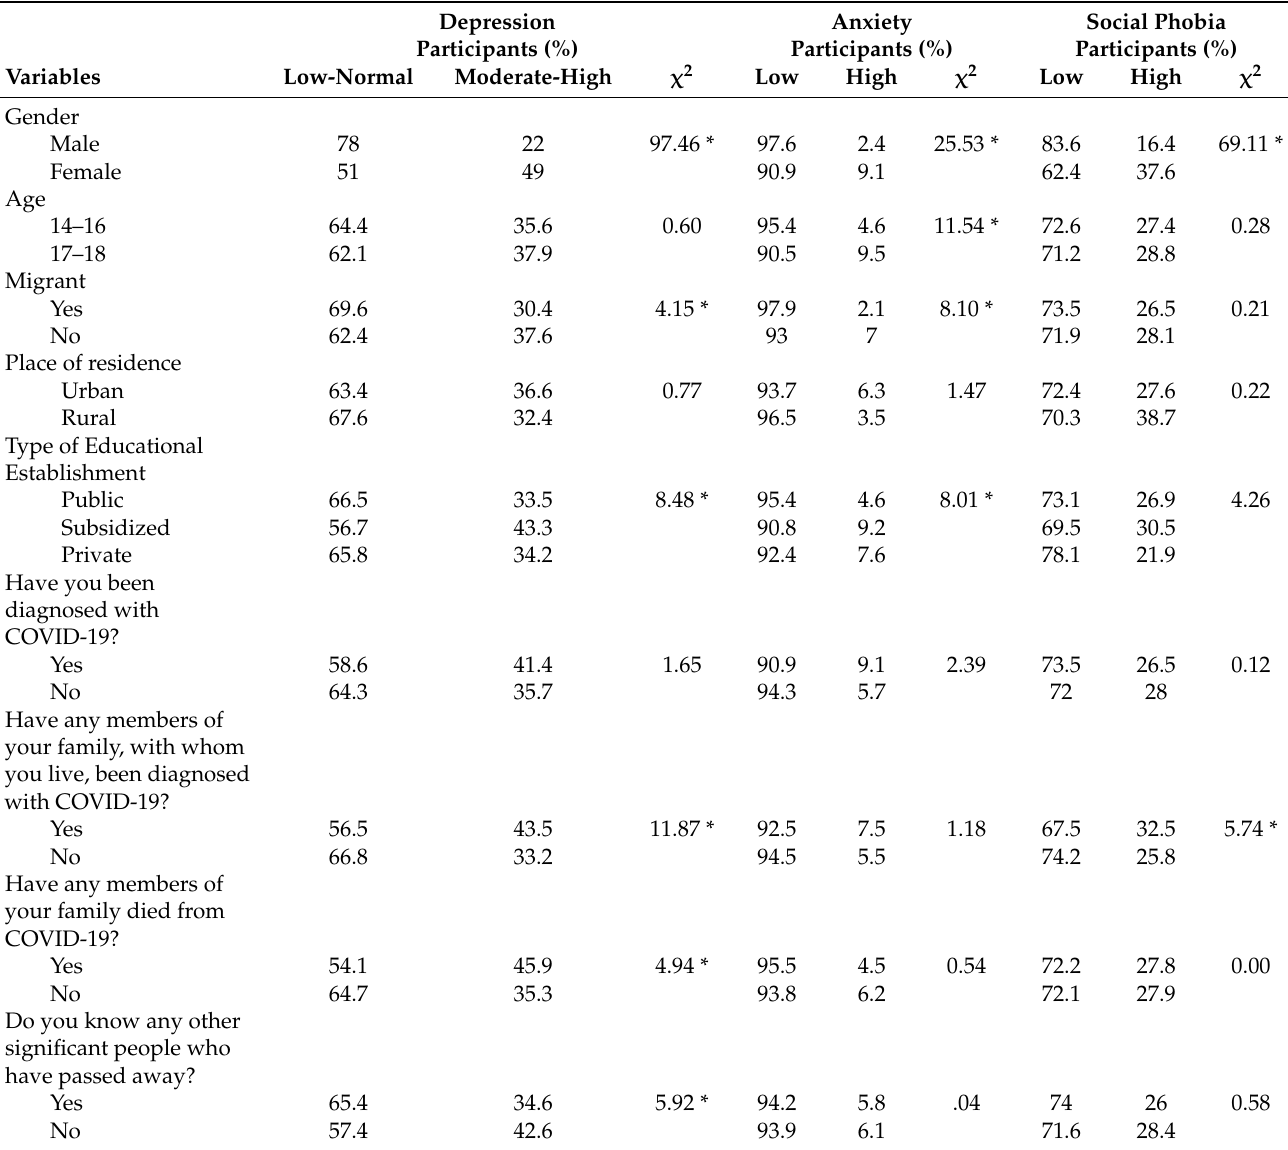
Table 4. Association of sociodemographic and COVID-19-related variables with symptomatology levels. Depression Anxiety Social